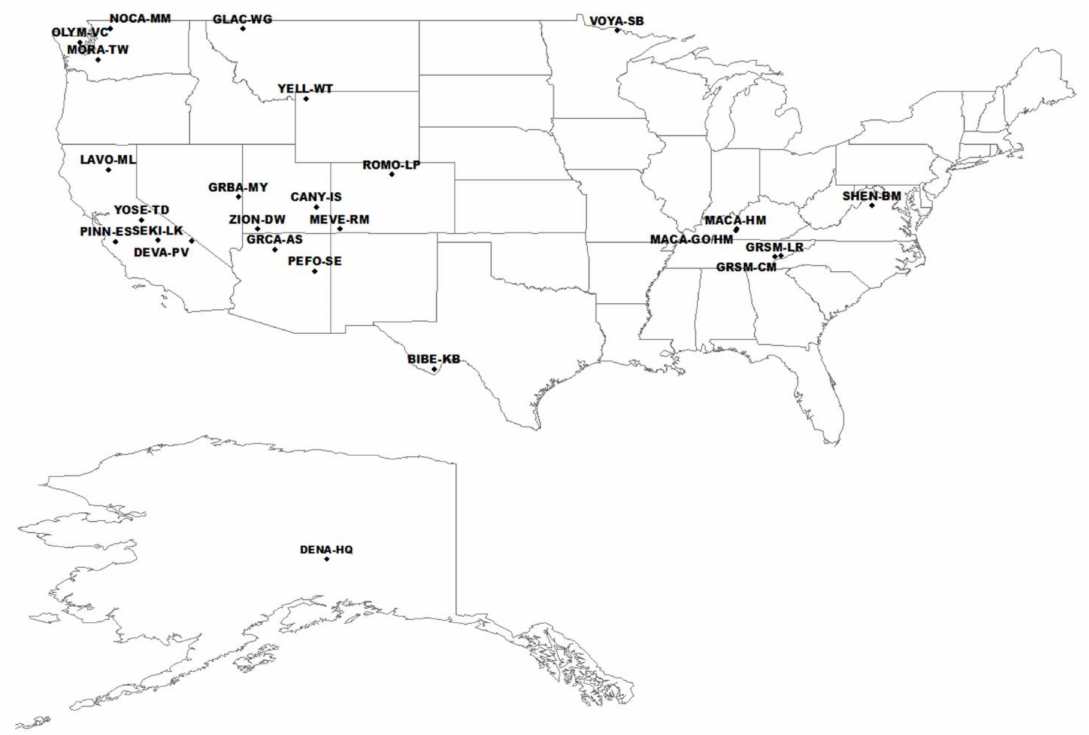
Figure 1. Locations of the 25 U.S. National Park Service sites used in this